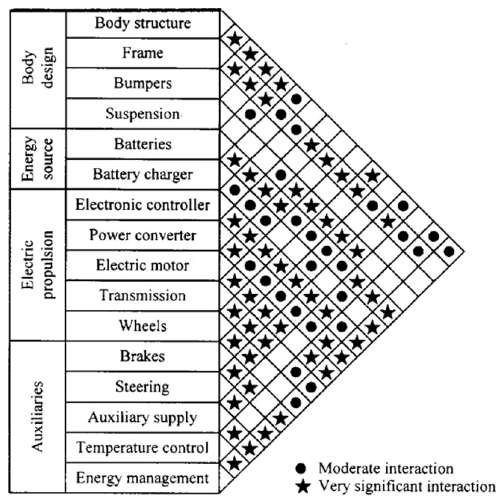
Figure 1. Different subsystems and their interaction with electric vehicles [36]. Figure 1. Di ff erent subsystems and their interaction with electric vehicles